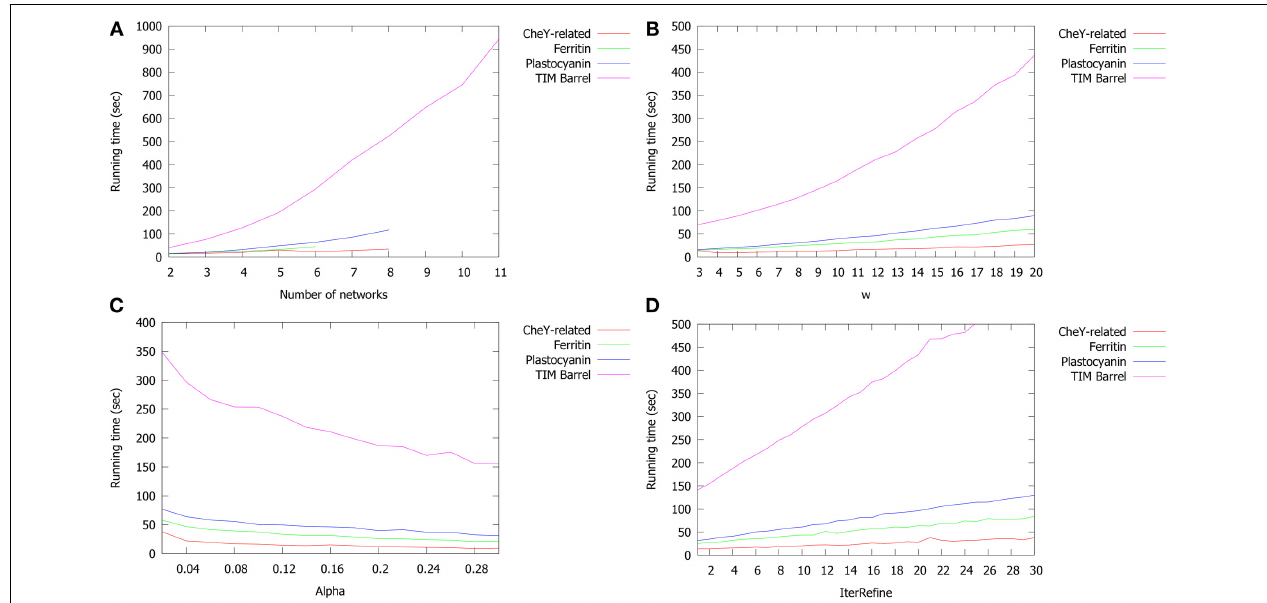
FIGURE 10 | Running time of PROPOSAL as a function of (A) number of proteins (N); (B) w; (C) α ; (D) iterRefine. Default values: N = 6, w = 15, α = 0 . 05, IterRefine = 10.